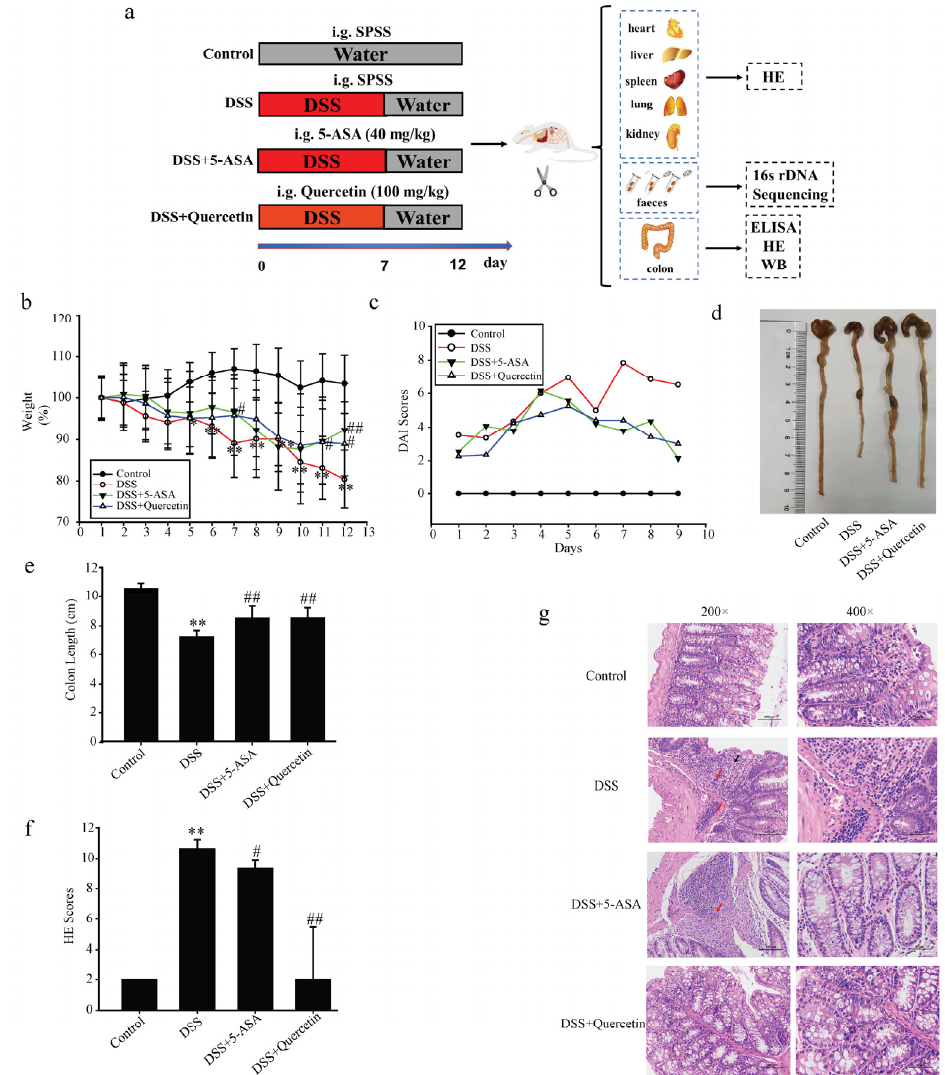
Figure 1. Quercetin reduces colon inflammation and damage induced by dextran sodium sulfate (DSS). ( a ) Flow chart of the experimental design. ( b ) Body weights of mice in the control, DSS, DSS + quercetin, and DSS + 5-aminosalicylic acid (5-ASA) groups. ( c ) Disease activity index. ( d , e ) Macroscopic appearance and the length of colons from each mouse group. ( f ) Histological changes. ** p < 0.01 compared with the control group; # p < 0.05, ## p < 0.01 compared with the DSS group. ( g ) Hematoxylin and eosin staining of colonic sections. Infiltration of inflammatory cells in the mucosa or submucosa is indicated by black and red arrows, respectively.